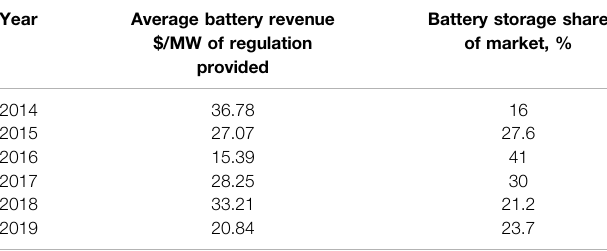
TABLE 5 | Battery revenues and market shares in the PJM regulation market, 2014 –